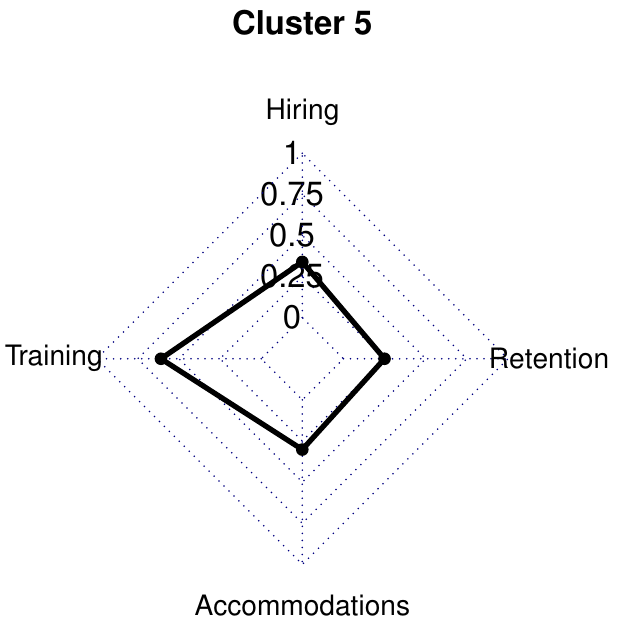
Figure 6. Cluster 5 radar